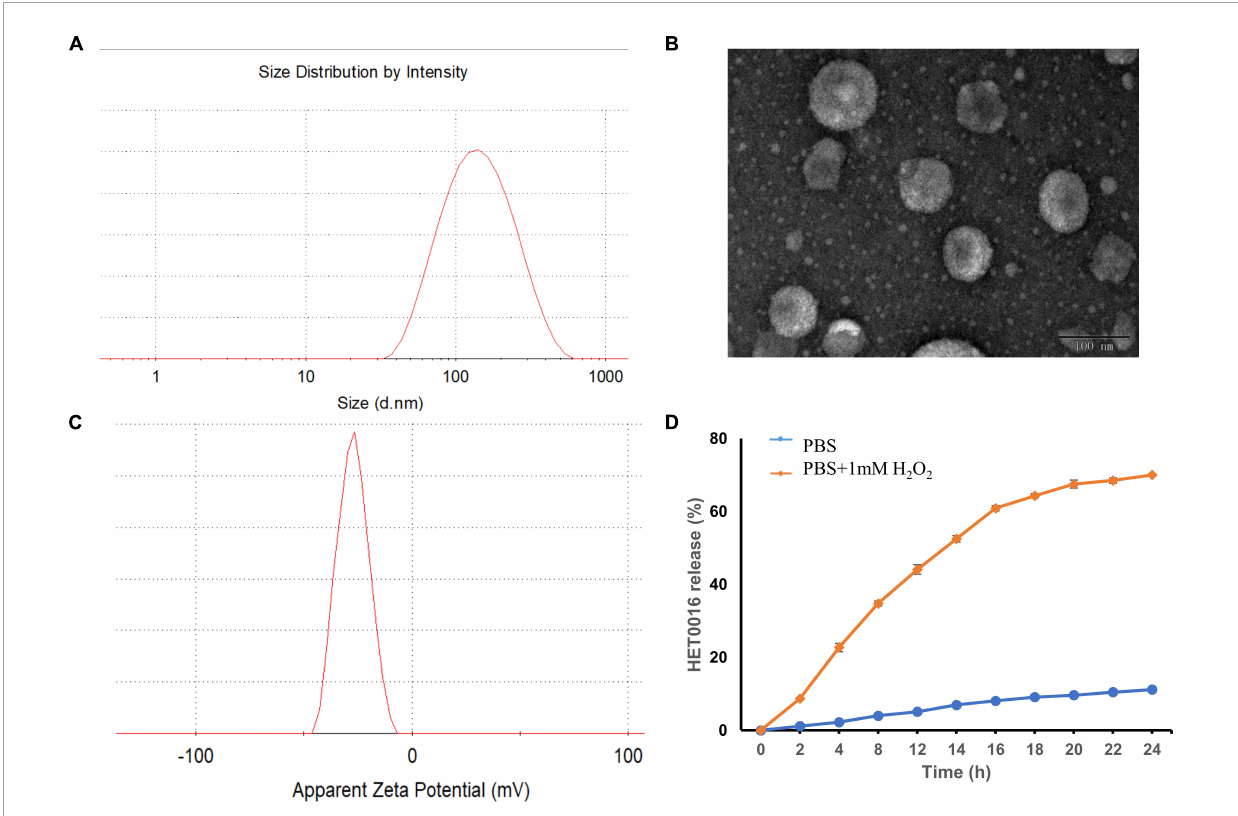
FIGURE3 The characterization of HPLs. (A) The particle size distribution. (B) TEM image of the HPLs, scale bar = 100 nm. (C) The particle zeta distribution. (D) In vitro release profiles of HET0016 from HPLs in PBS (pH 7.4) and PBS (pH 7.4) with 1 mM H 2 O 2 . Experiments were performed in triplicate and value were mean ± SD.